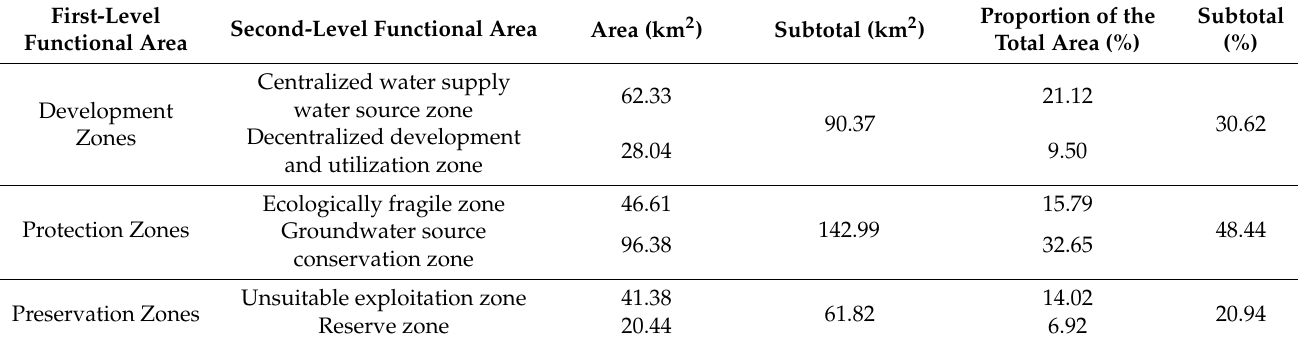
Figure 9. Functional zoning of shallow groundwater in the study area. According to the above shallow groundwater functional zoning map, the area and proportion of each first-level and second-level functional area are calculated in this paper. The statistical results are shown in Table 4. Table 4. Statistical table of groundwater functional areas in the study